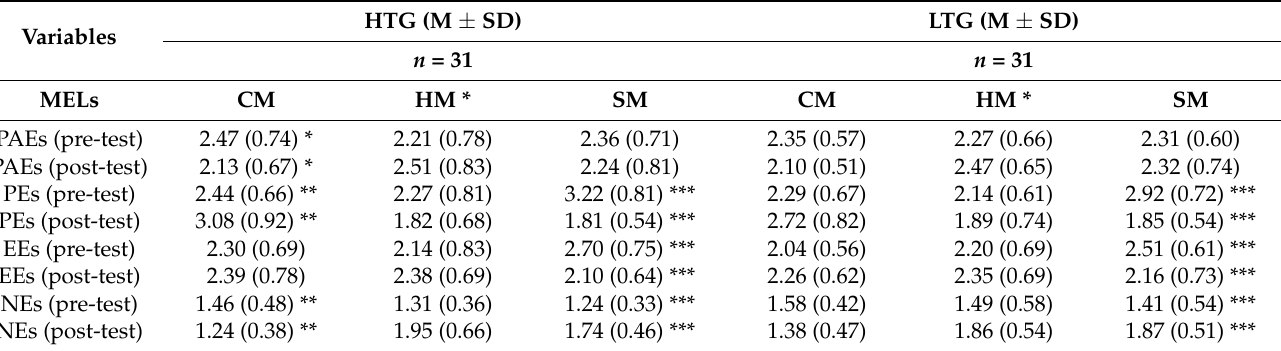
Table 3. Descriptive statistics of AESTHEMOS results.